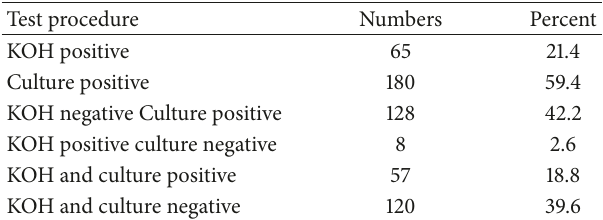
Table 2: Testing methods and